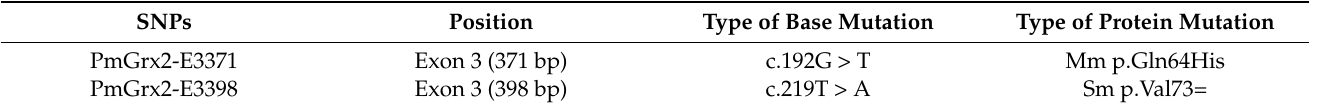
Table 1. Specific information of the SNPs of PmGrx2 .